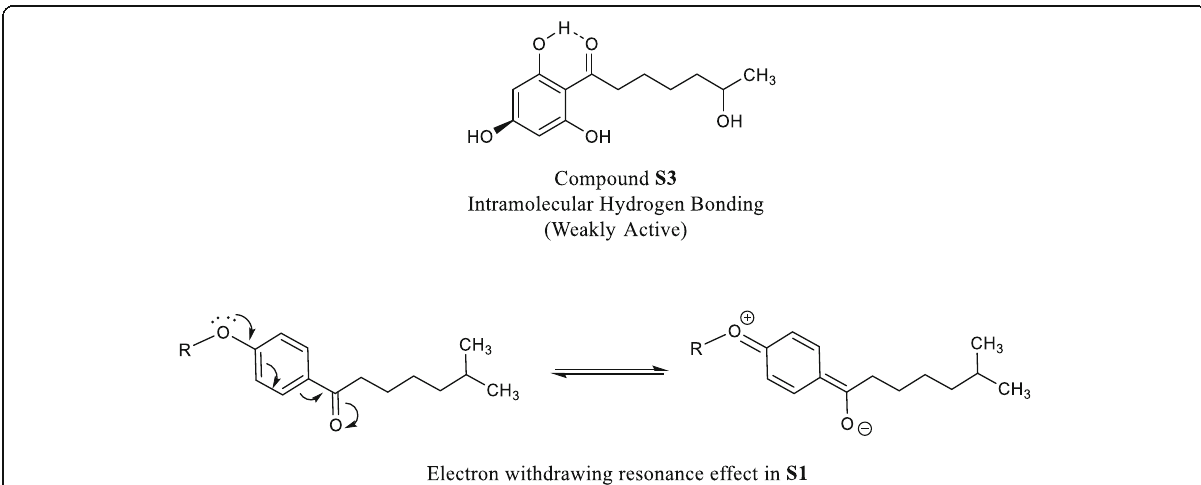
Fig. 3 Intramolecular hydrogen bonding interaction of I. heterantha (S3)